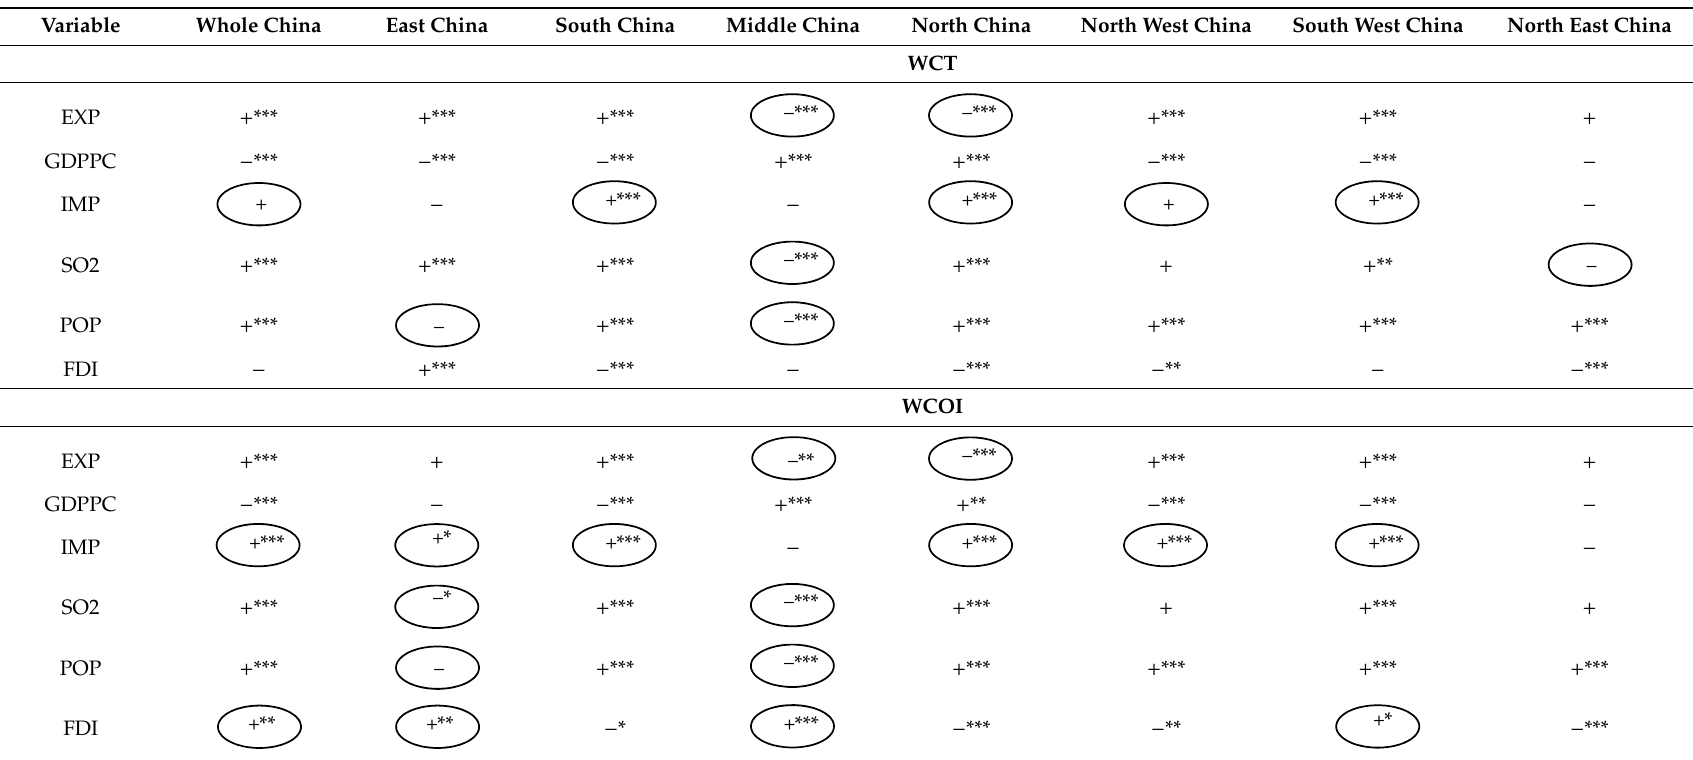
Table 8. FMOLS (Fully modified ordinary least squares) estimates and the sign comparison—actual signs.